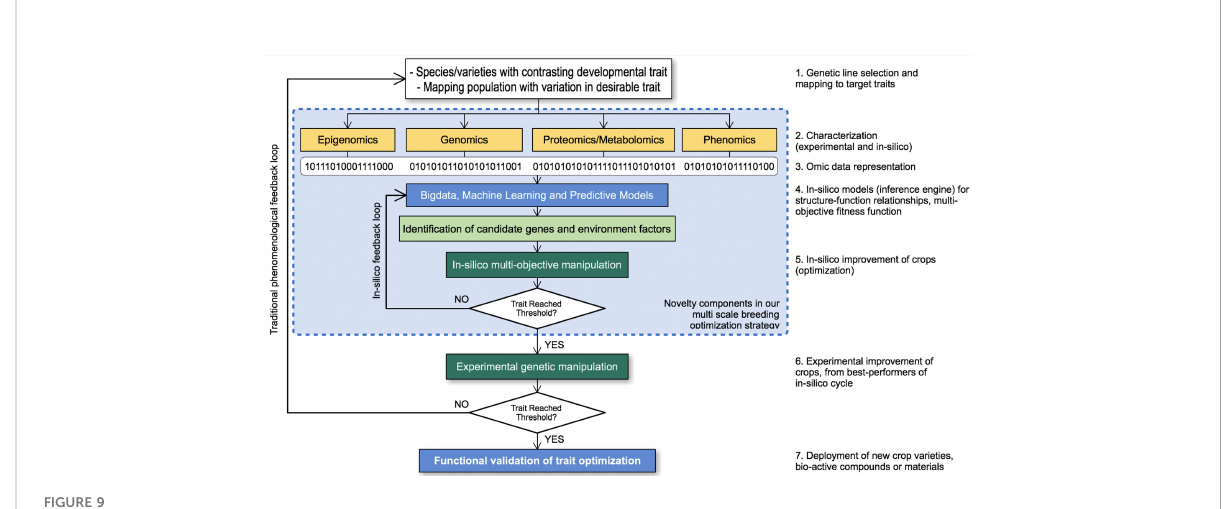
FIGURE 9 In-silico characterization strategy in